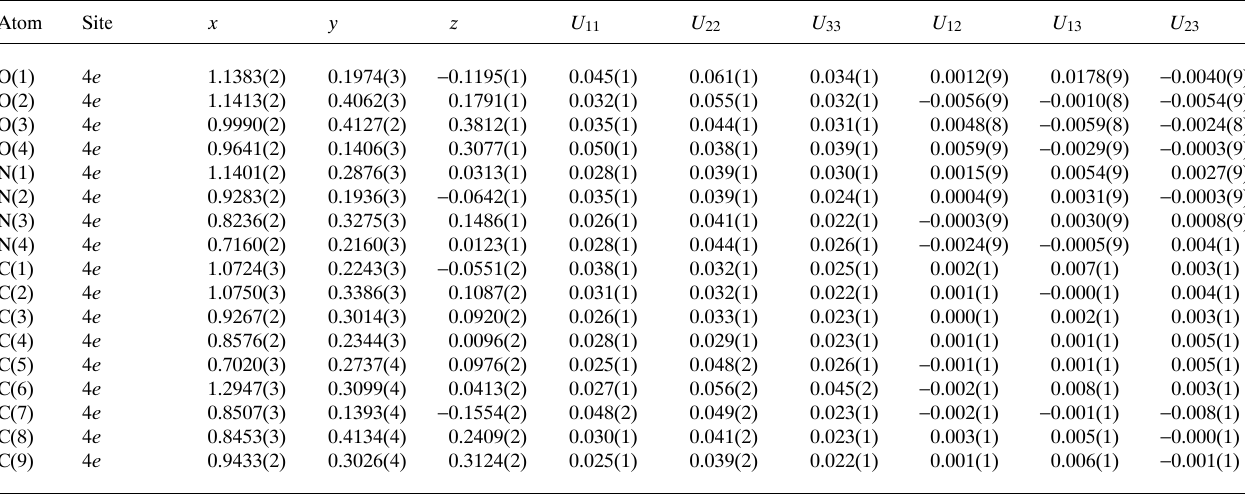
Table 3. A tomic coordin a tes a nd displ a cement p a r a meters (in Å 2 )